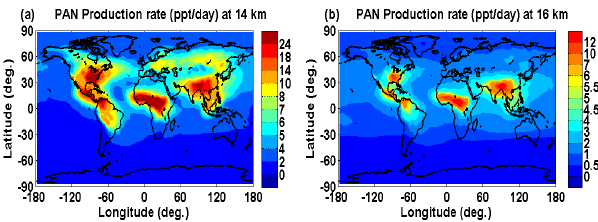
Figure 1. PAN production rates at (a) 14km and (b) 16km. Key re- gions of biomass burning and anthropogenic emissions of pollutants are evident and correspond to maxima in PAN production. Weaker dispersed background formation is evident as